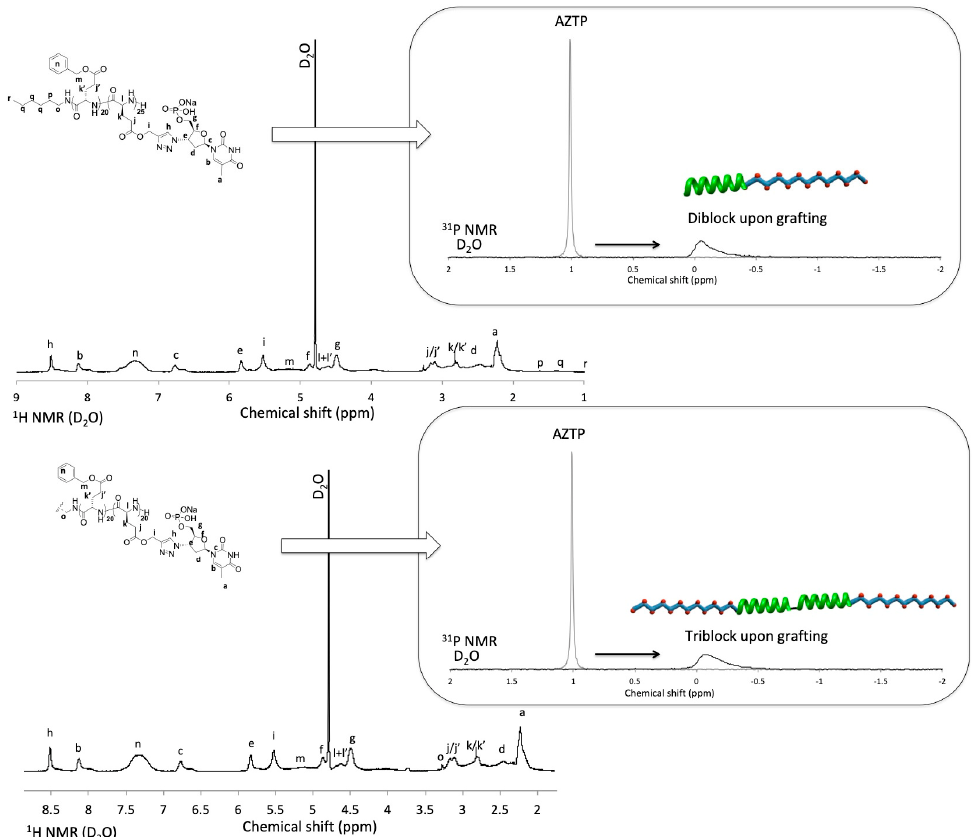
Figure 3. 1 H NMR (left) and 31 P NMR (right) analyses of the thymidine-containing diblock copolymer (PBLG- b -PPLGNu) (top) and triblock copolymer (PPLGNu- b -PBLG- b -PPLGNu) (down). Solvent: D 2 O, 31 P NMR depicts a superposition of spectra of AZTP and the copolymer upon CuAAc grafting (drawings: PBLG in green, PPLG in blue and red dots for AZTP).